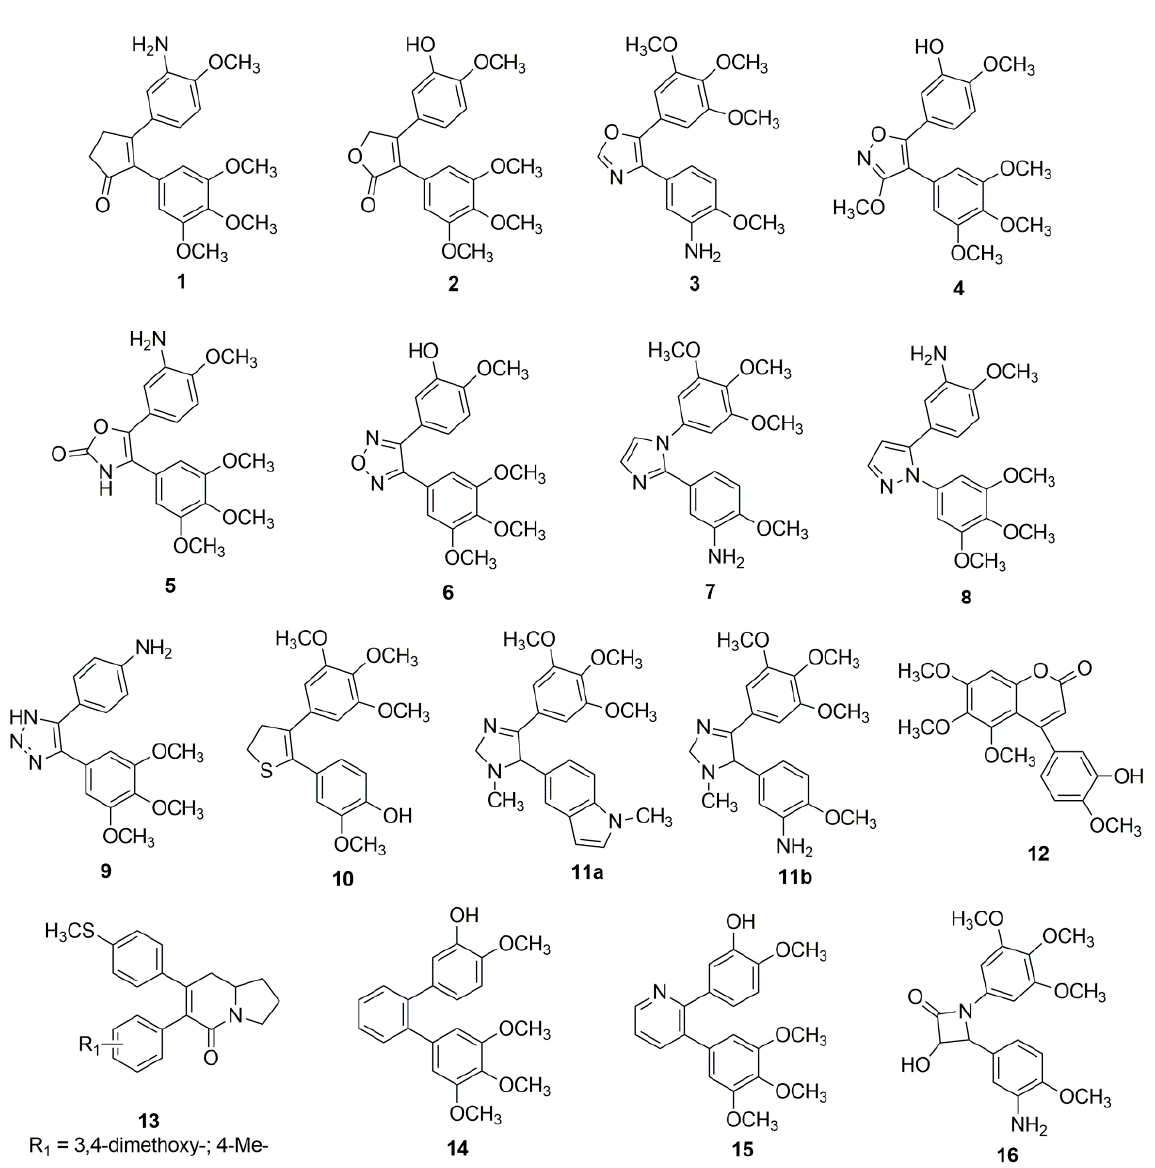
zoles (Figure 1 ( 8 )) [29], triazoles (Figure 1 ( 9 )) [33], 2,3-dihydrothiophenes (Figure 1 ( 10 )) [34], 4,5-disubstituted imidazoles (Figure 1( 11a and 11b ) [29], and arylcoumarins (Figure 1 ( 12 )) [35] have been reported. 2,3,8,8a-Tetrahydro-5(1H)-indolizinones (Figure 1 ( 13 )) [36], benzene and pyridine (Figure 1 ( 14 )) and (Figure 1 ( 15 )) [30] were also used as six-membered rings; two reports have appeared with three-membered rings [37,38]. Among the four-membered rings, azetidone analogs (Figure 1 ( 16 )) were prepared [39] (Figure 1).